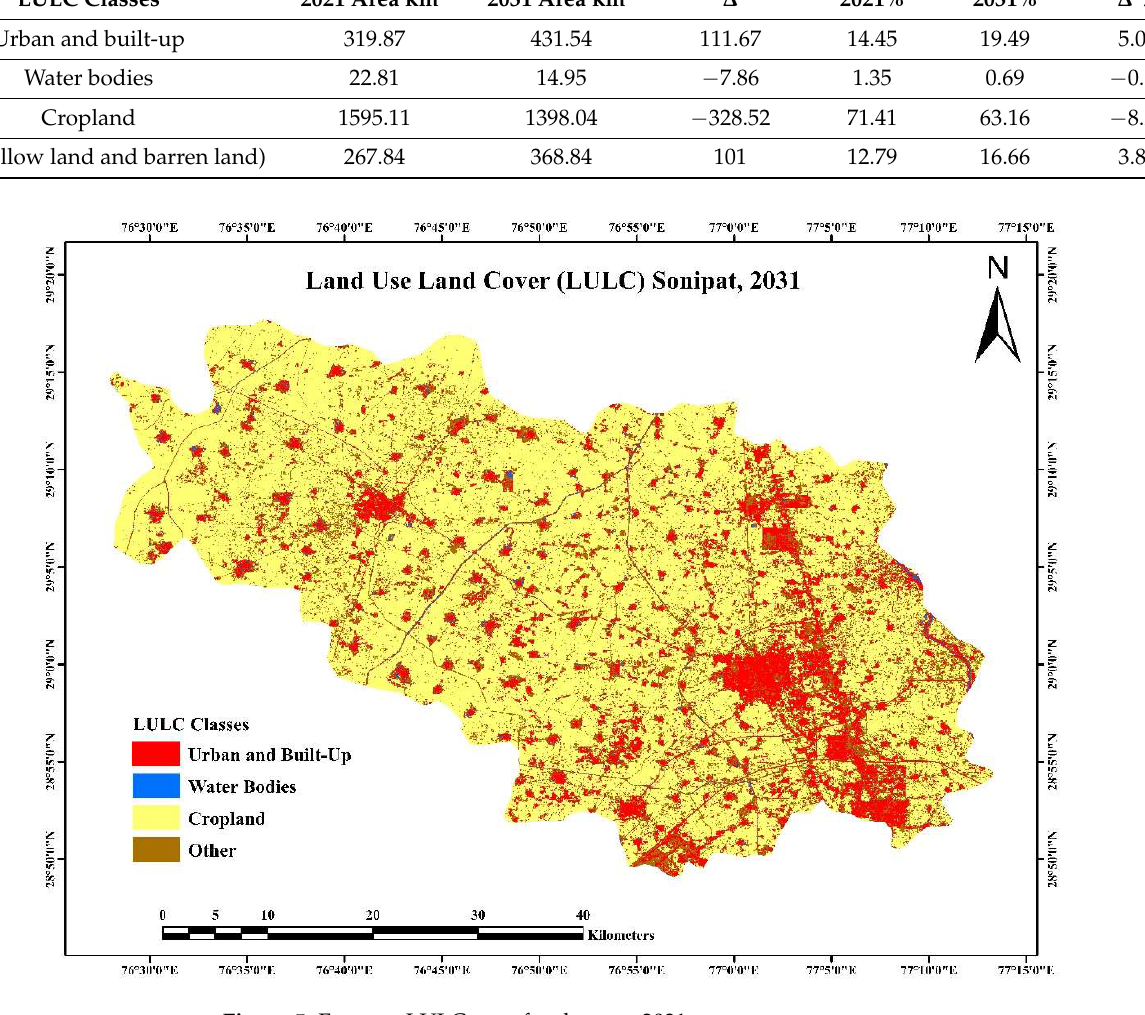
Figure 5. Forecast LULC map for the year 2031.